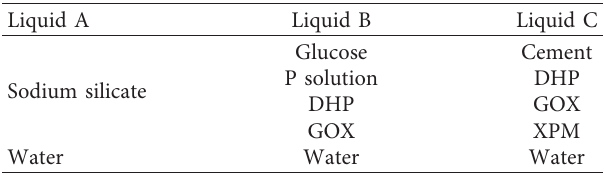
Table 1: Components of